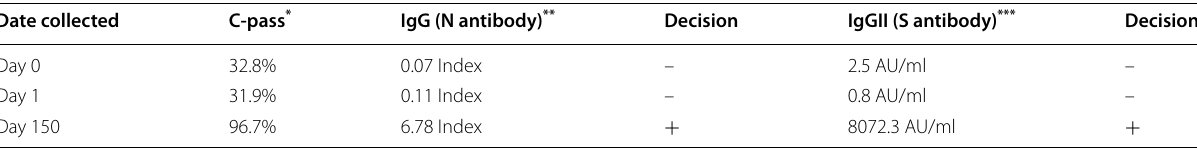
Table 1 Changes in neutralizing antibodies against